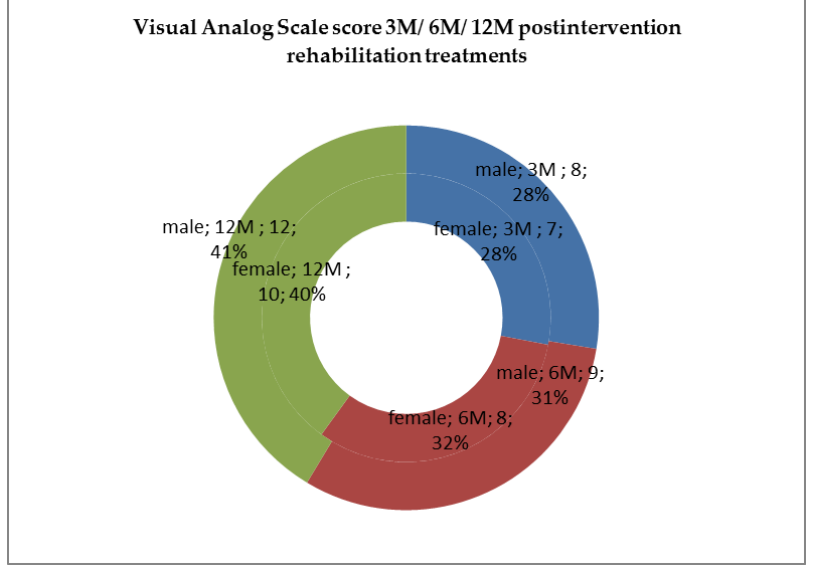
Figure 16. The score obtained from the results of Visual Analog Scale 3 M 6 M 12 M, postintervention.